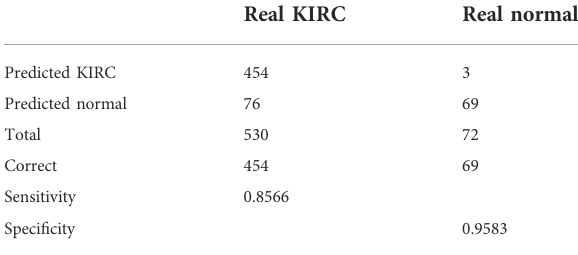
TABLE 2 Sensitivity and speci fi city of the diagnostic